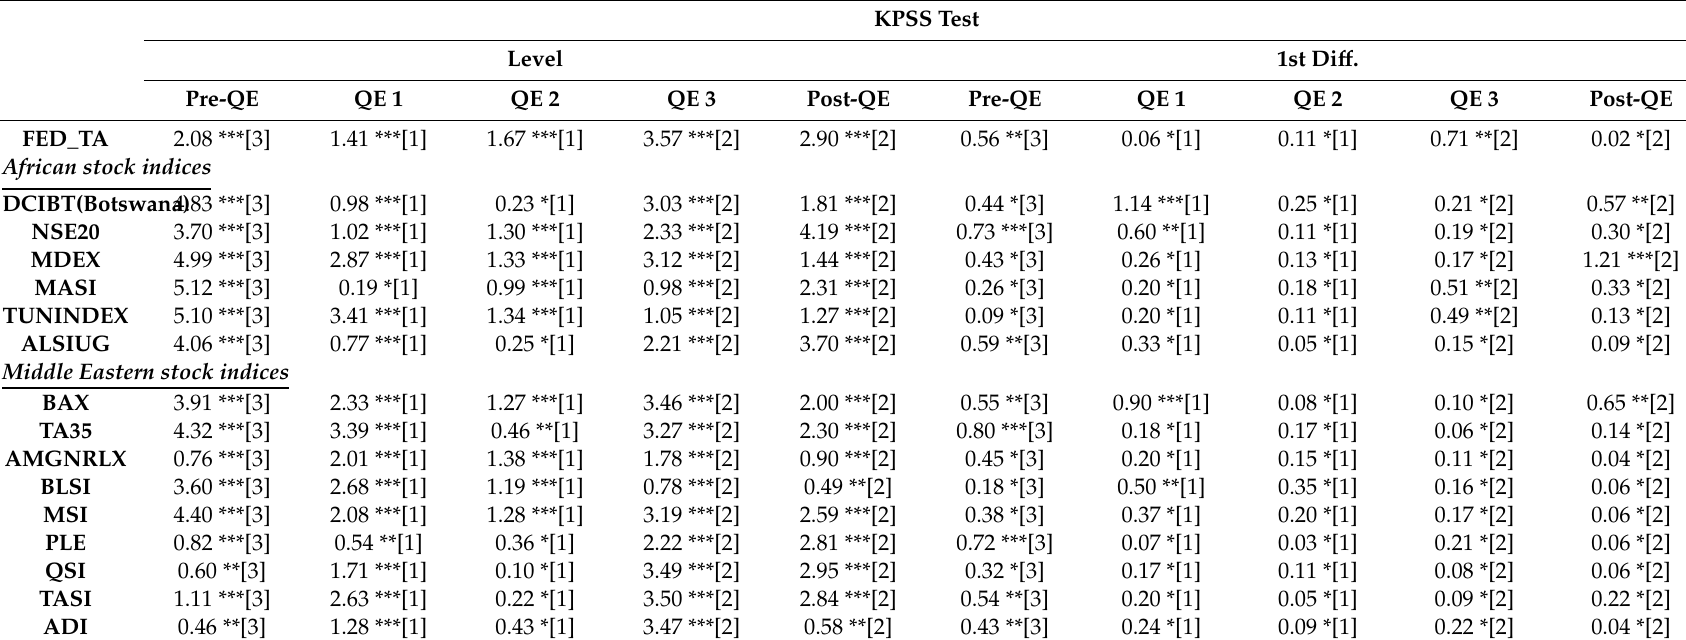
Table 5. Unit roots tests results based on the Kwiatkowski et al. (KPSS)